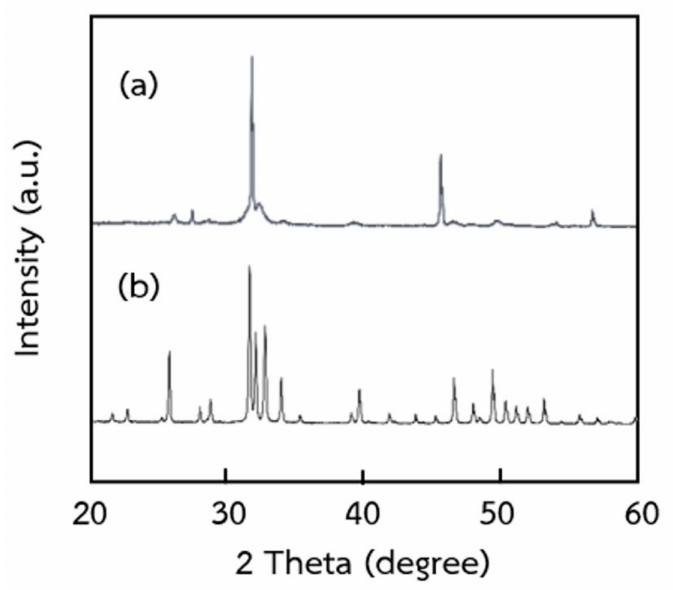
Figure 5. XRD patterns of ( a ) extracted hydroxyapatite using 5% HCl with 60 min extraction time and ( b ) commercial